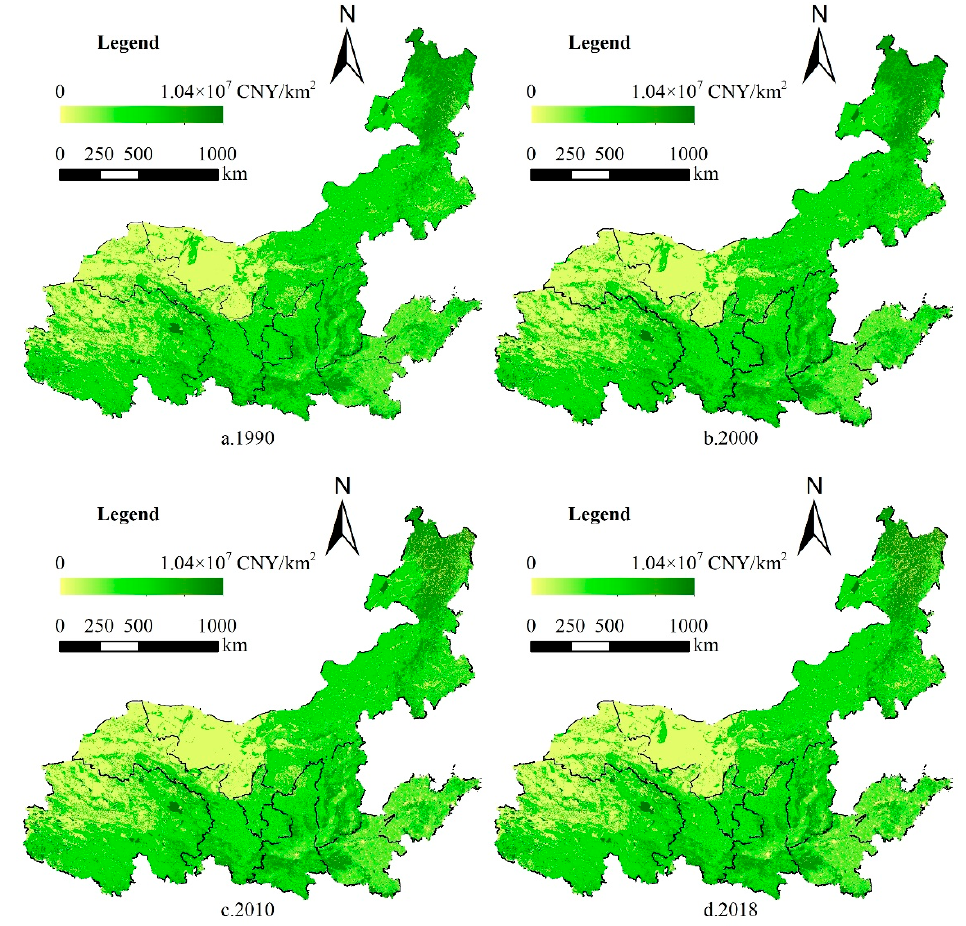
Figure 4. Spatial distribution of ESV per unit area in the YRB during 1990–2018.